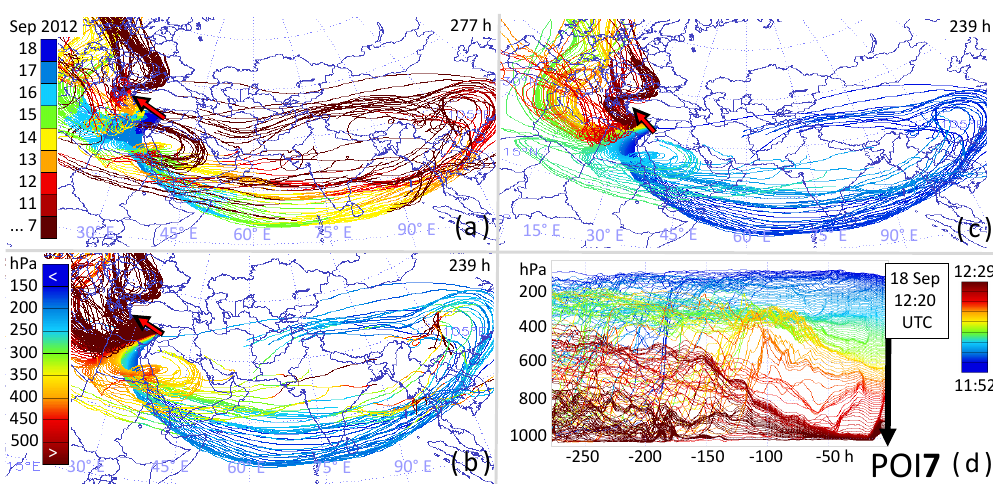
Figure A6. As Fig. 3, but for POI7. This flight segment covers the descent into